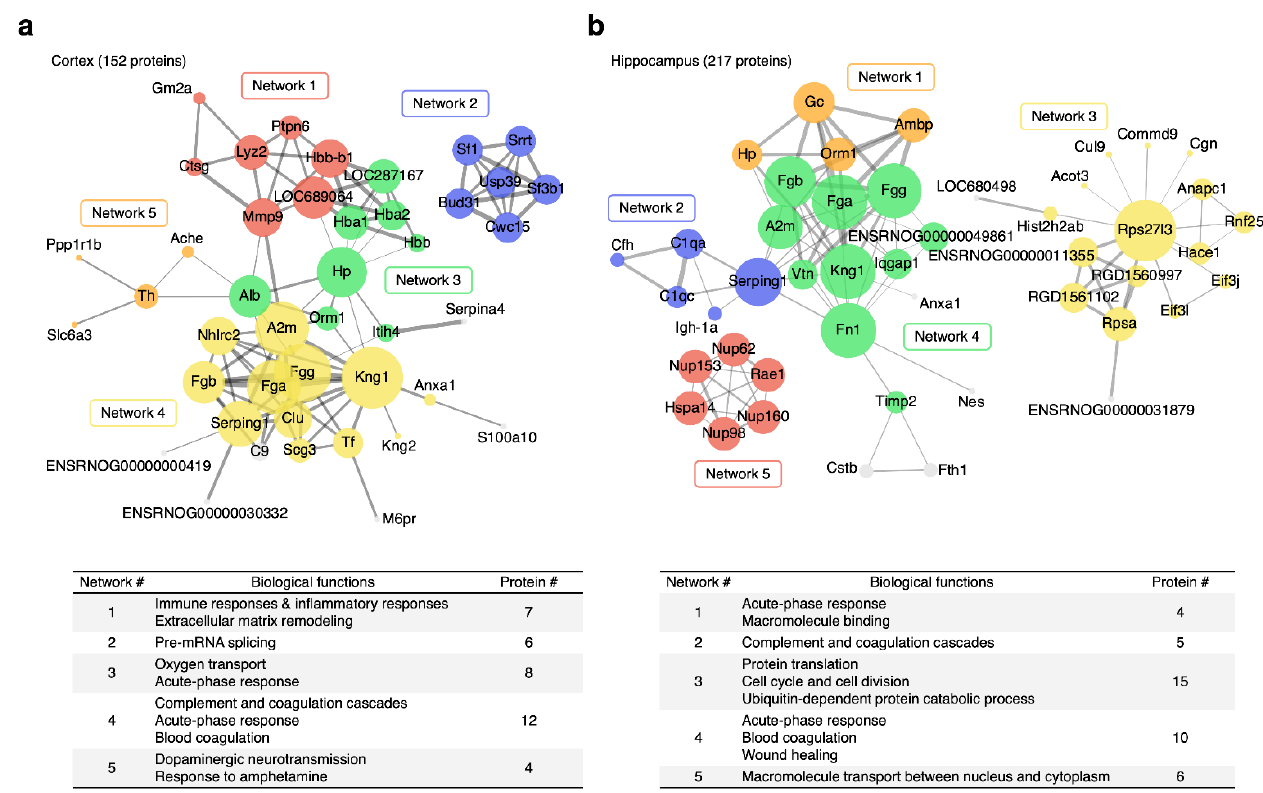
Figure 4. Protein – protein interaction (PPI) networks enriched from MA-unique APs in ( a ) cortex and ( b ) hippocampus using STRINGDB. Only networks with high confidence (STRING score > 0.7) and > 3 nodes were retained.